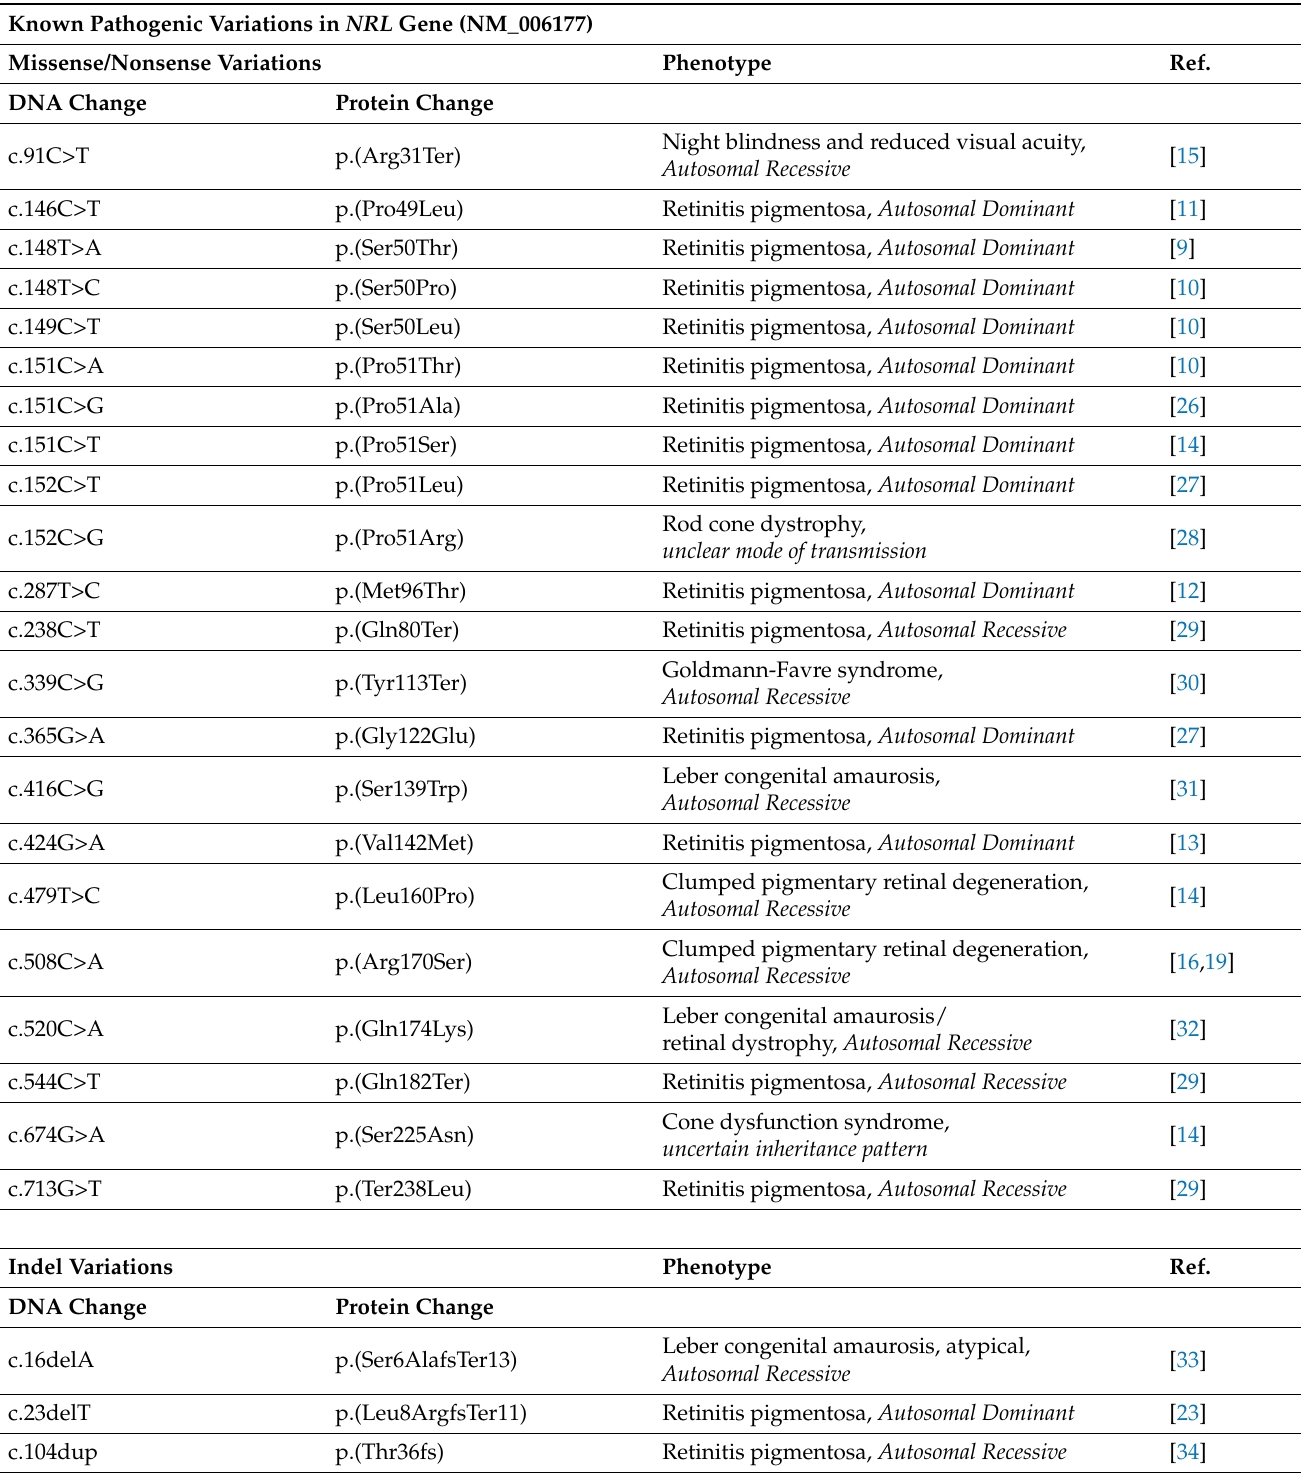
Table 1. Known pathogenic variations in the NRL